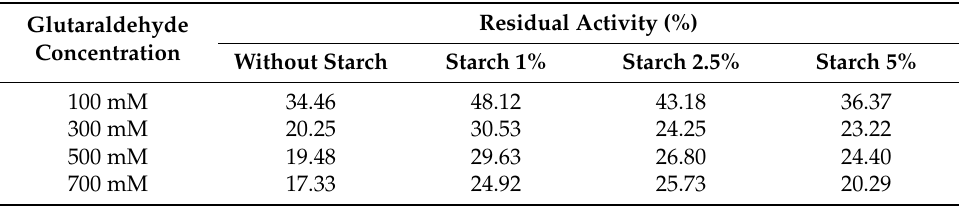
Table 2. Effect of glutaraldehyde on the free amyloglucosidase activity in the presence or absence of starch. Residual activity was measured after 16 h incubation at 4 °C and the initial activity was taken to be 100%.